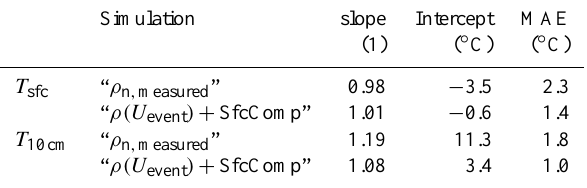
Table 3. Regression of modelled versus measured snow tempera- tures, slope intercept and mean absolute error (MAE), for the period 19 February to 20 March 2008, corresponding to Fig. 6. T sfc is snow surface temperature and T 10cm the snow temperature measured at 10-cm depth, both in ◦ C. The simulation names are explained in Table 2. Simulation slope Intercept MAE